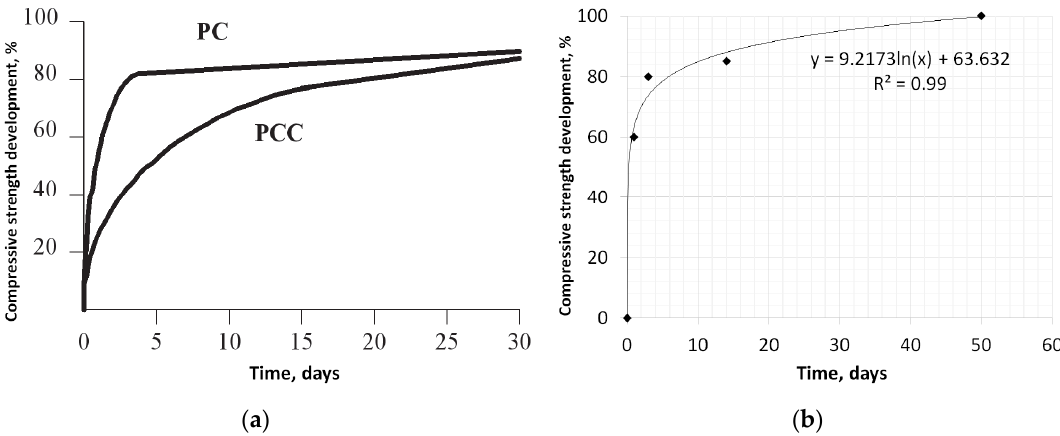
Figure 1. Development of the compressive strength of polymer composites expressed as the relative increase in time: ( a ) model of polymer concrete (PC) and polymer-cement concrete (PCC) developed by Czarnecki [2]; ( b ) recalculation of the first model using the natural logarithm function.